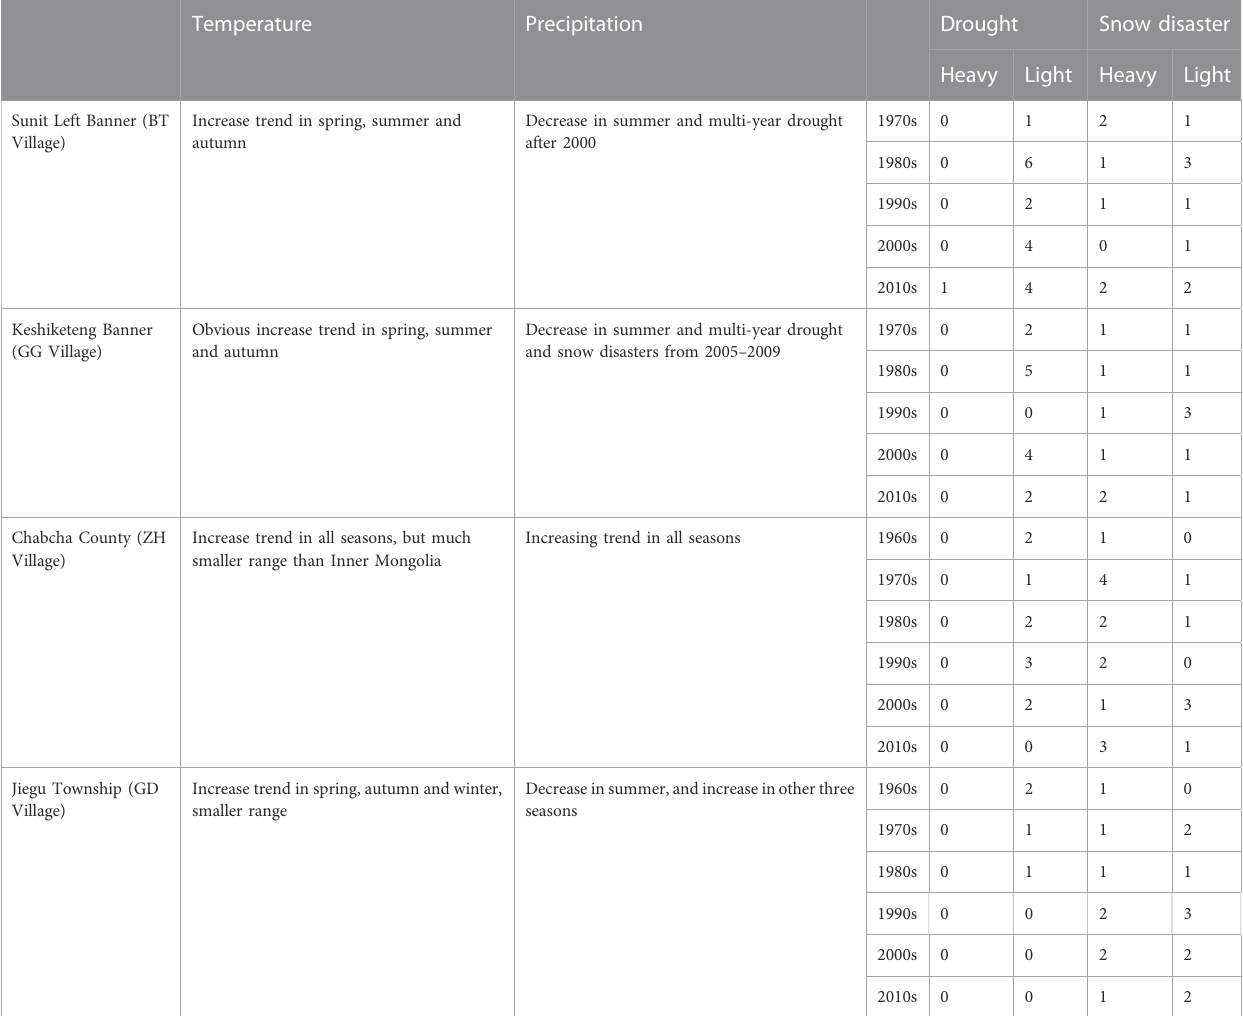
TABLE 2 Climate change characters and natural disasters frequency of four cases. Temperature